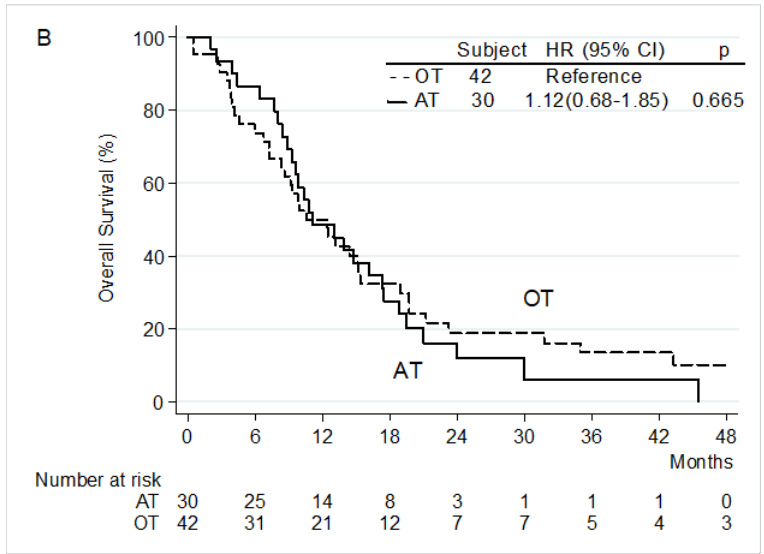
Figure 2. Analysis of disease extent as predictive factor for overall survival benefit from approved treatments. Extrahepatic spread ( A ) and intrahepatic disease ( B ), p value for disease extent treatment interaction = 0.005.